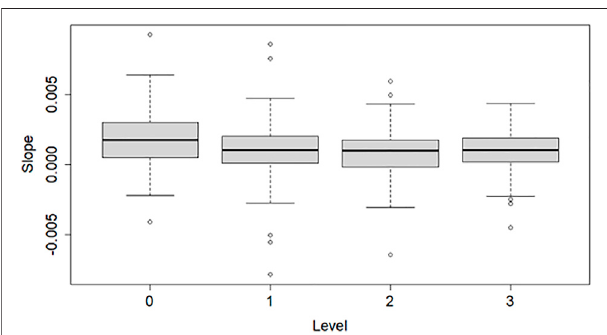
FIGURE 5 | Comparison of the NDVI increases over time, indicated as positiveslopevalues,amongthedifferentlevelsofprotection(DF=3,368,F=